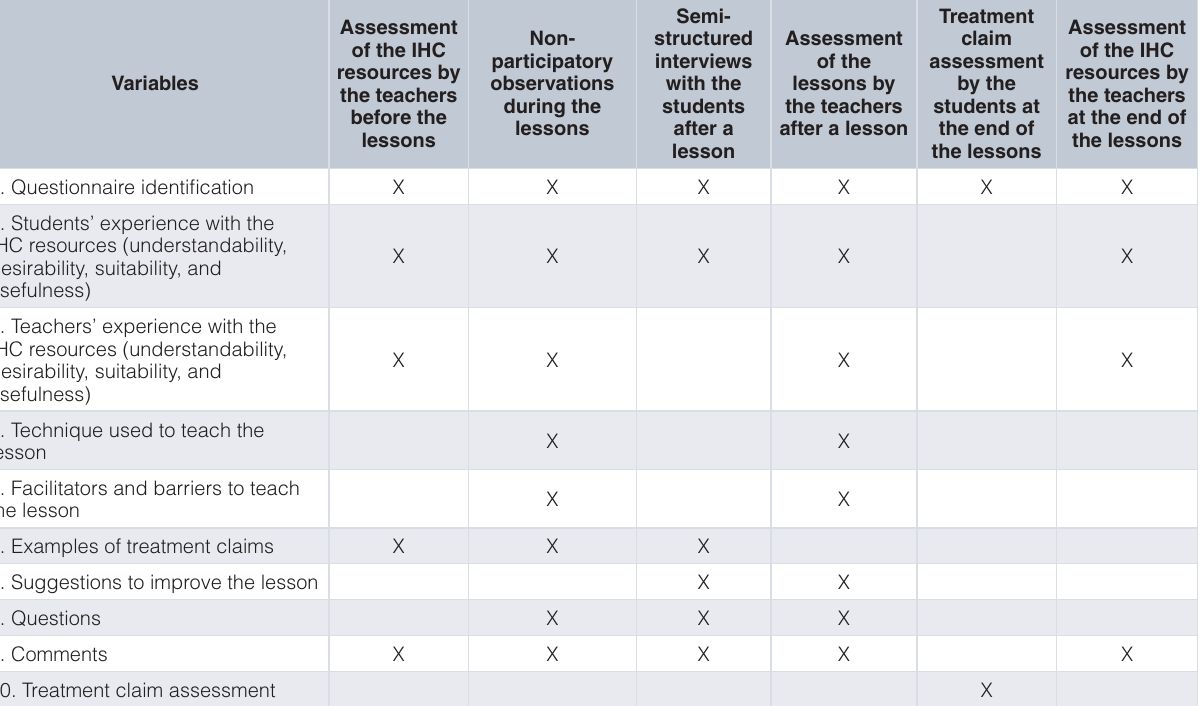
Table 3. Pilot study